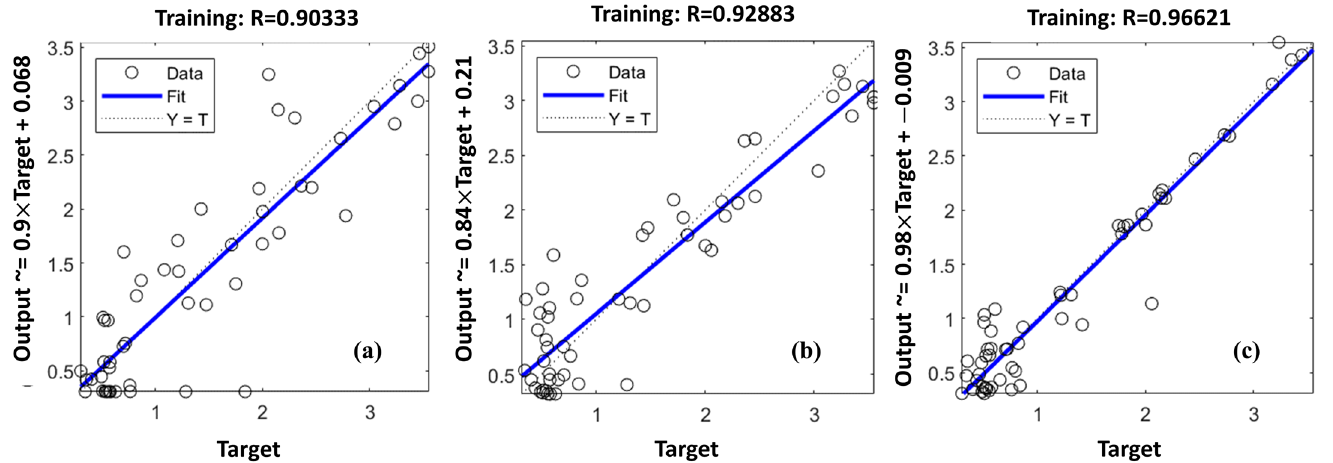
Figure 8. ANN training scatter plots of predicted UCS against measured UCS for ( a ) M1, ( b ) M2, and ( c ) M3.